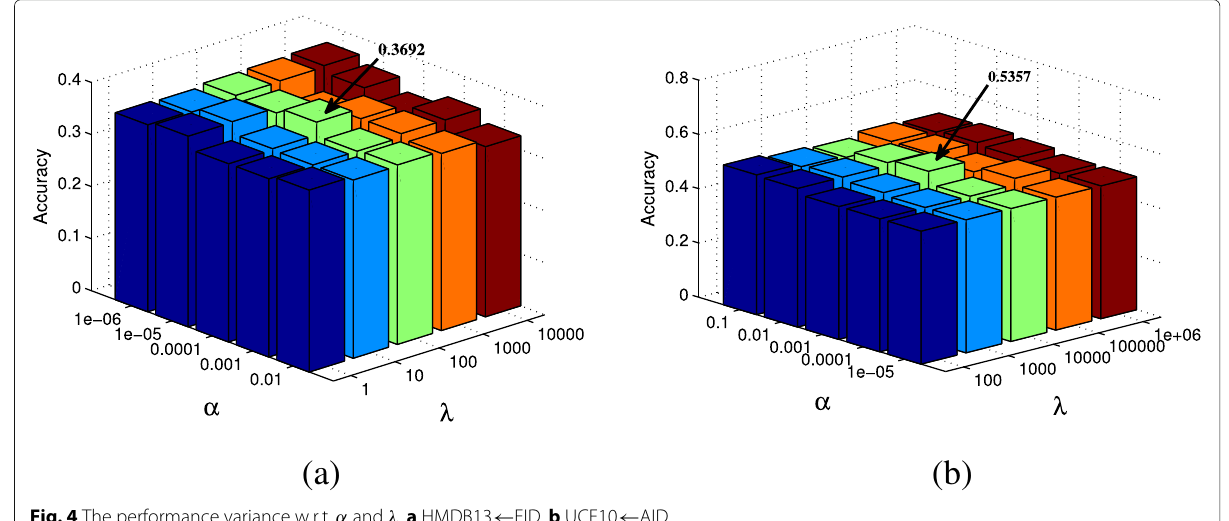
Fig. 4 The performance variance w.r.t. α and λ . a HMDB13 ← EID. b UCF10 ←